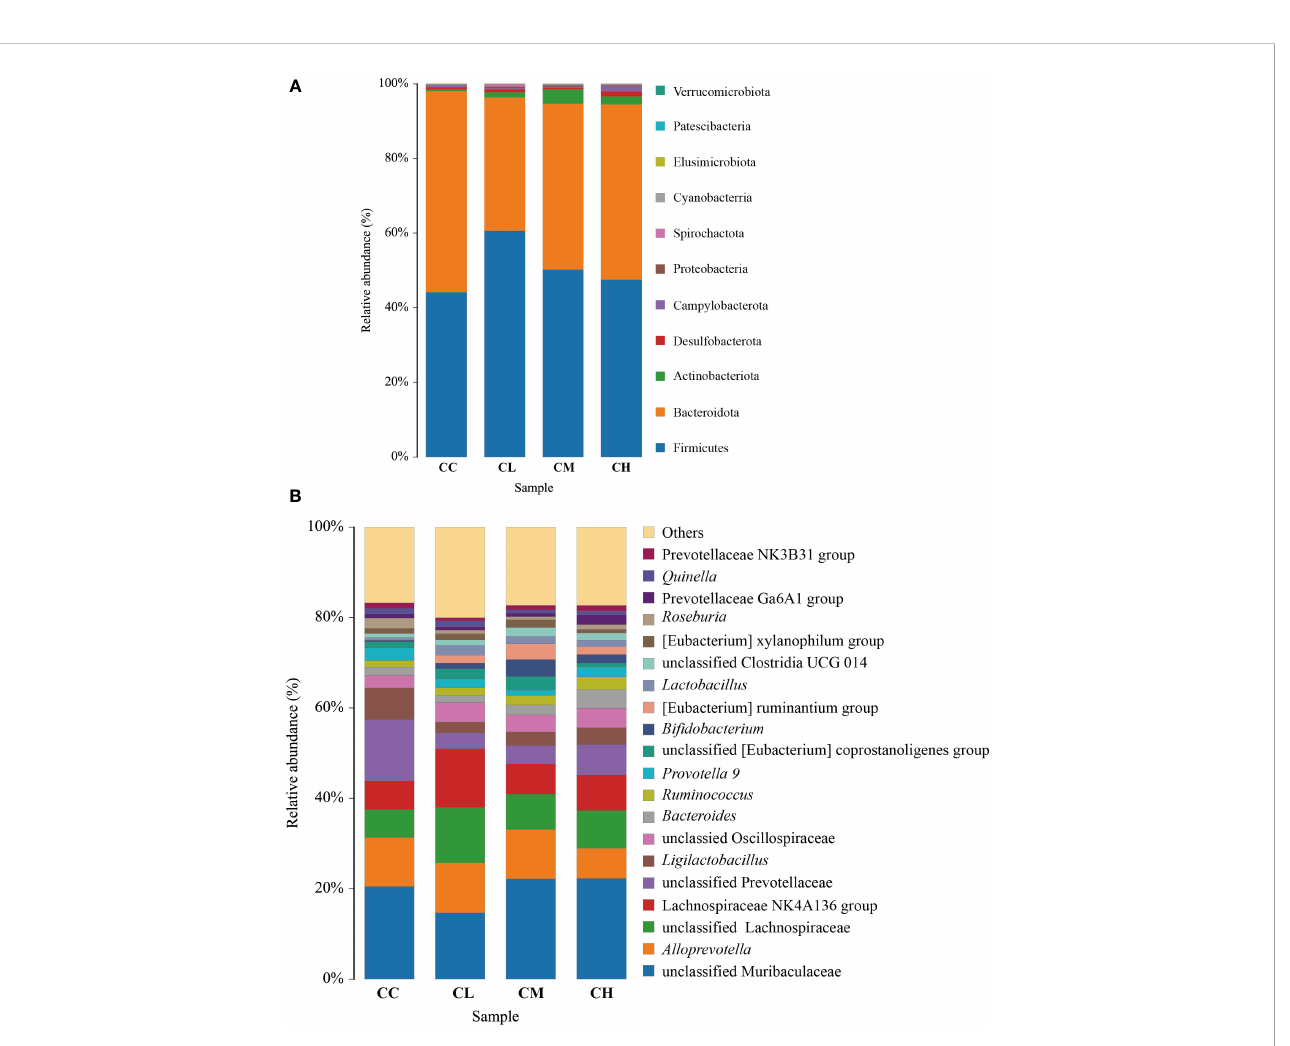
FIGURE 7 Relative abundance of bacteria in intestinal contents of mice after intervention with GFPS. (A) Level of phylum. (B) Level of genus. CC: control group, CL: low-dose GFPS group, CM: medium-dose GFPS group, CH: high-dose GFPS